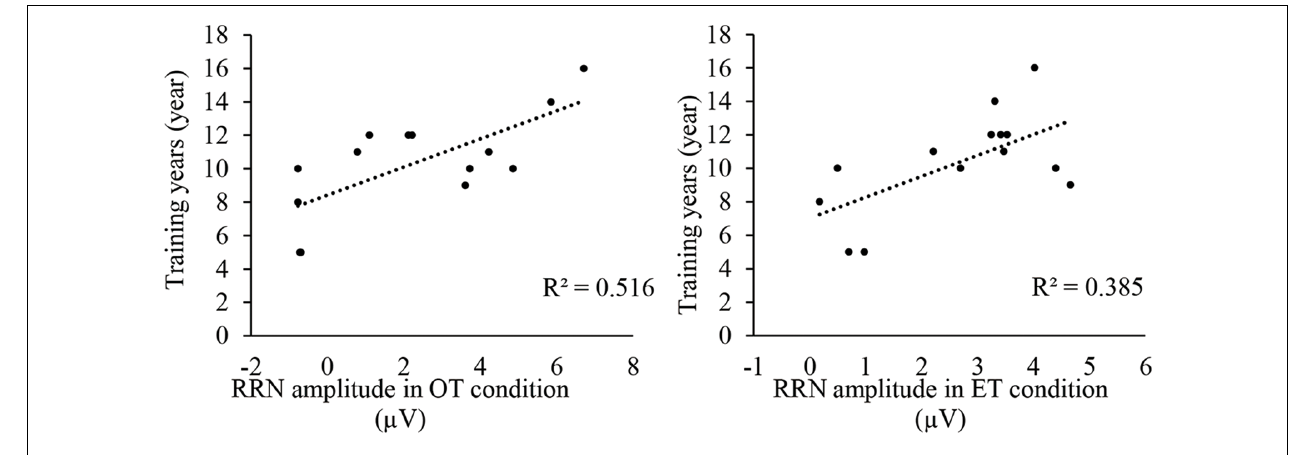
FIGURE 9 | Correlation between RRN amplitude (Pz) and training years for athletes in each condition.